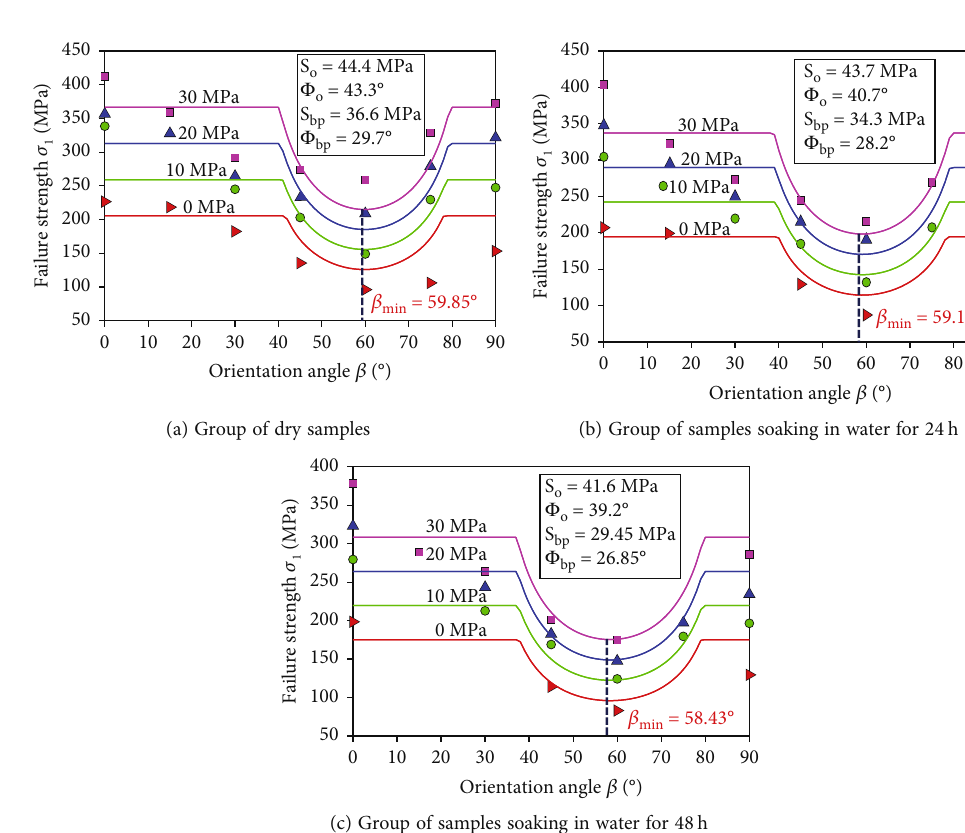
(c) Group of samples soaking in water for 48h Figure 4: Experimental data with di ff erent moisture content fi t by plane of weakness model.